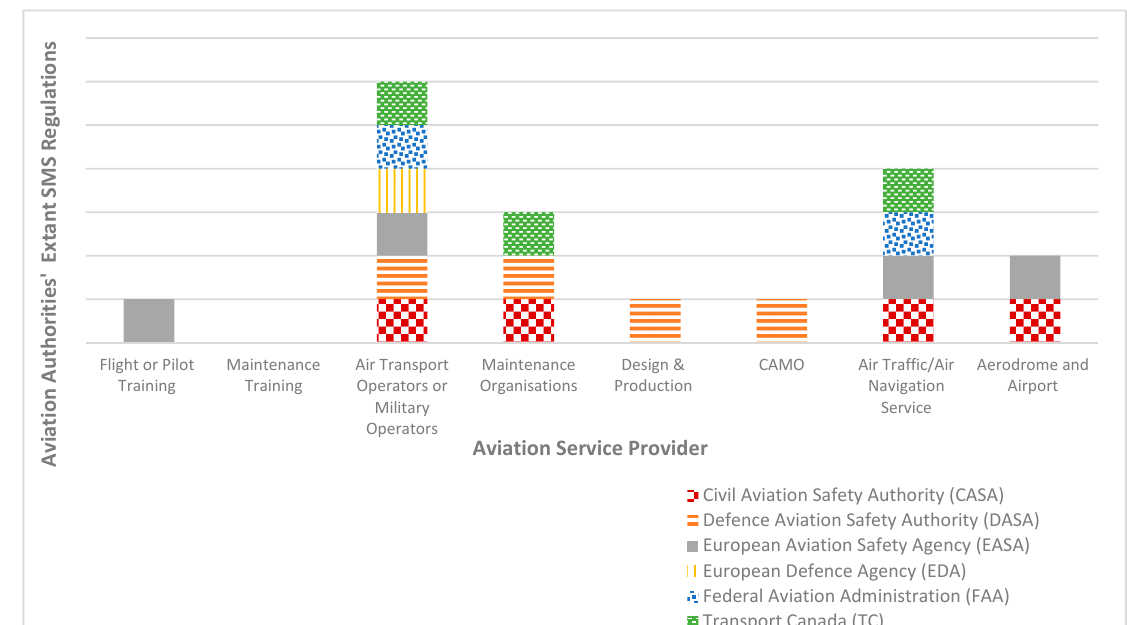
Figure 1. A comparison of Safety Management System regulations under key Aviation Authorities (as at June 2018).